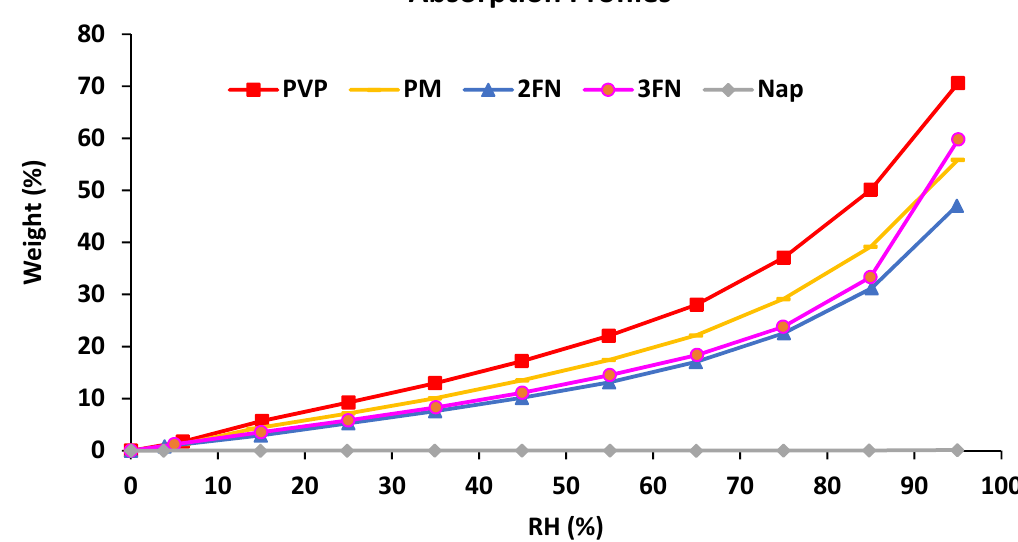
Figure 3. Moisture absorption profiles of raw materials, physical mixture, and two naproxen-PVP dispersions (2FN and 3FN) at 25 °C.